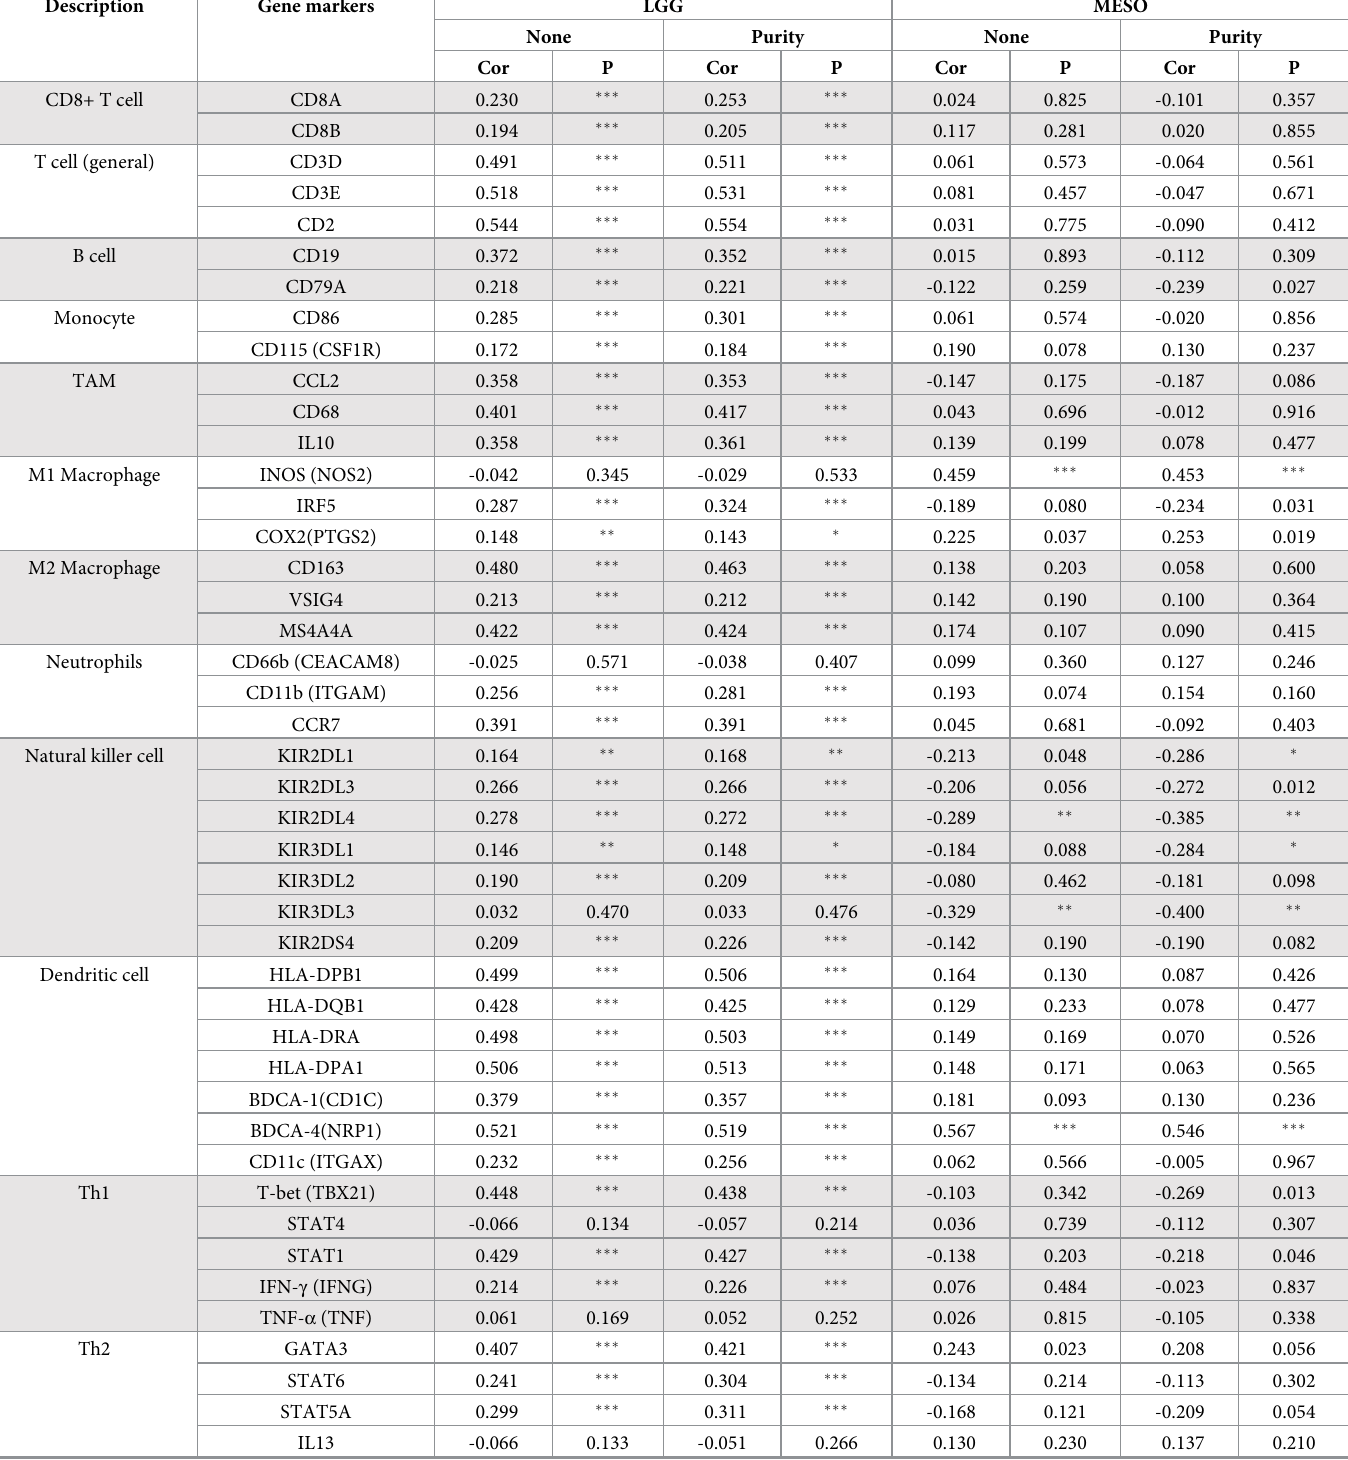
Table 3. Correlation analysis of COL1A1 expression level and immune cell markers in TIMER.